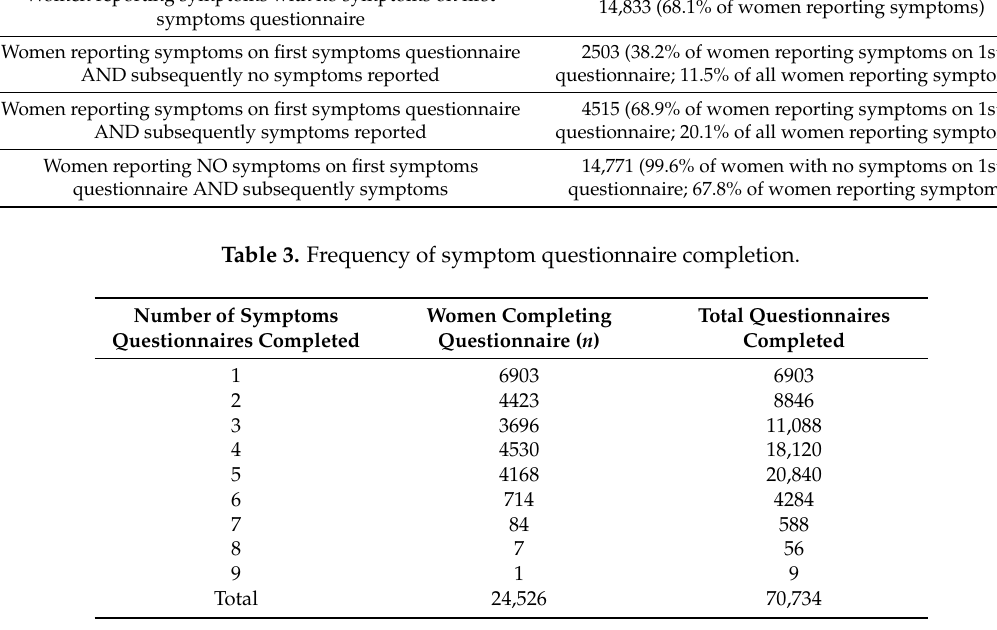
Table 4. Confidence as a function of the number of symptoms questionnaires